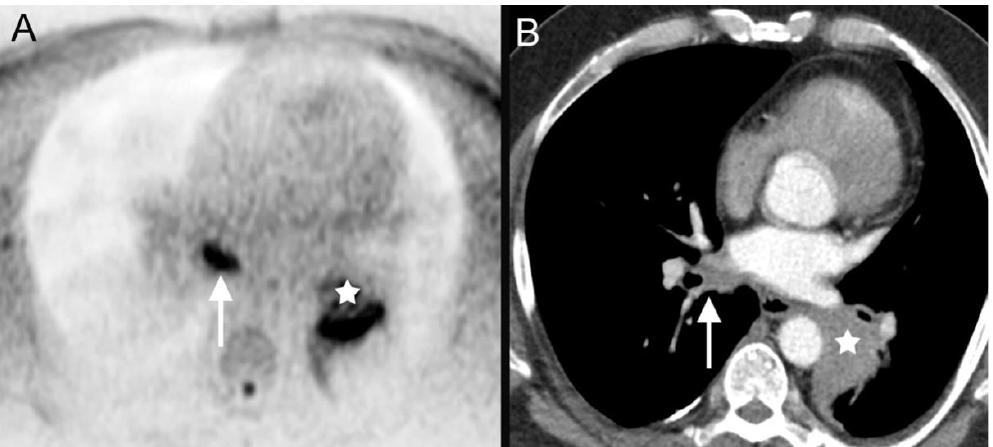
Figure 3. An 85-year-old male patient who was diagnosed with cancer of the right palatine tonsil (cT1 cN2b cM0) showed diffuse spotty diffusion restrictions in DWIBS of the skele- tal system with the largest lesions in the right sacral mass ( A , black arrow) and the 11th thoracic vertebrae on the left ( C, black arrow) without correlate in the CT ( B, D ) and was later diagnosed with multiple myeloma.